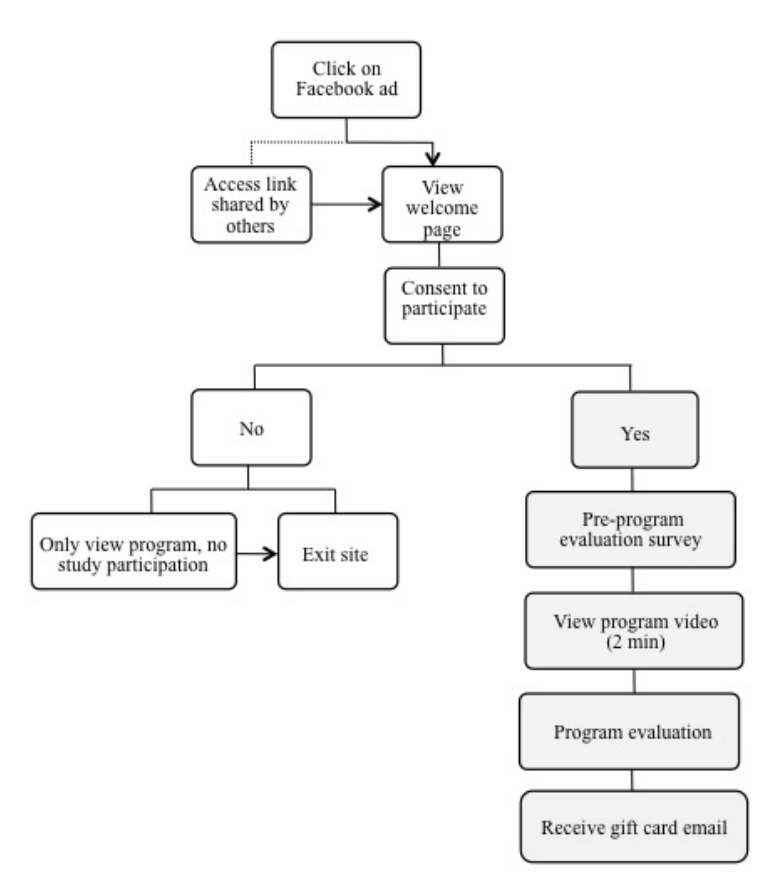
Figure 1. Program recruitment and evaluation